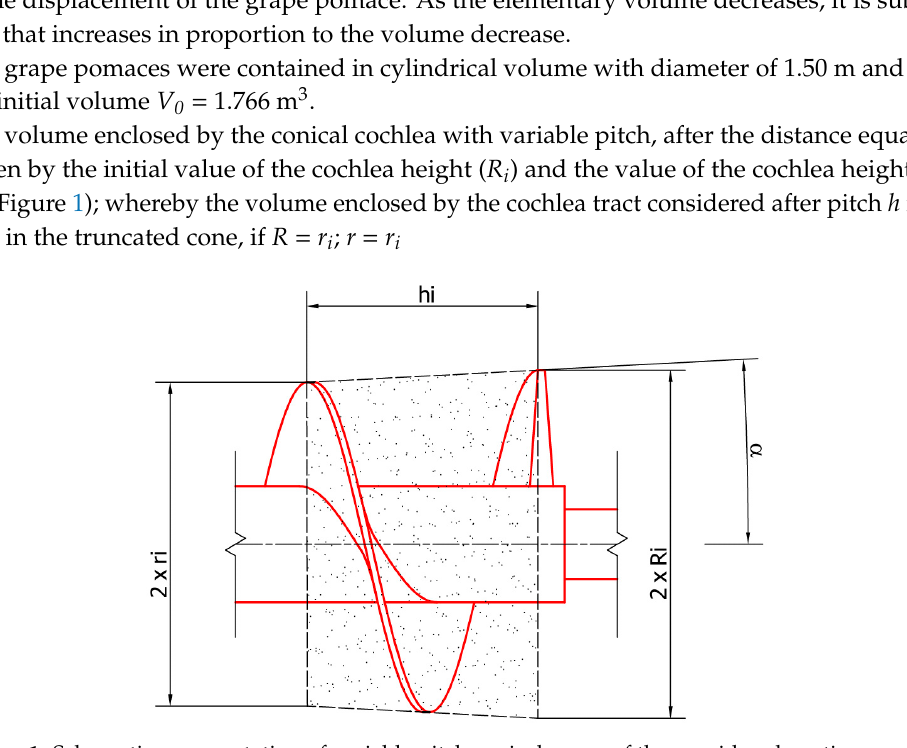
Figure 1. Schematic representation of variable pitch conical screw of the considered continuous press that performed the pressing process, with the variable used in this paper.